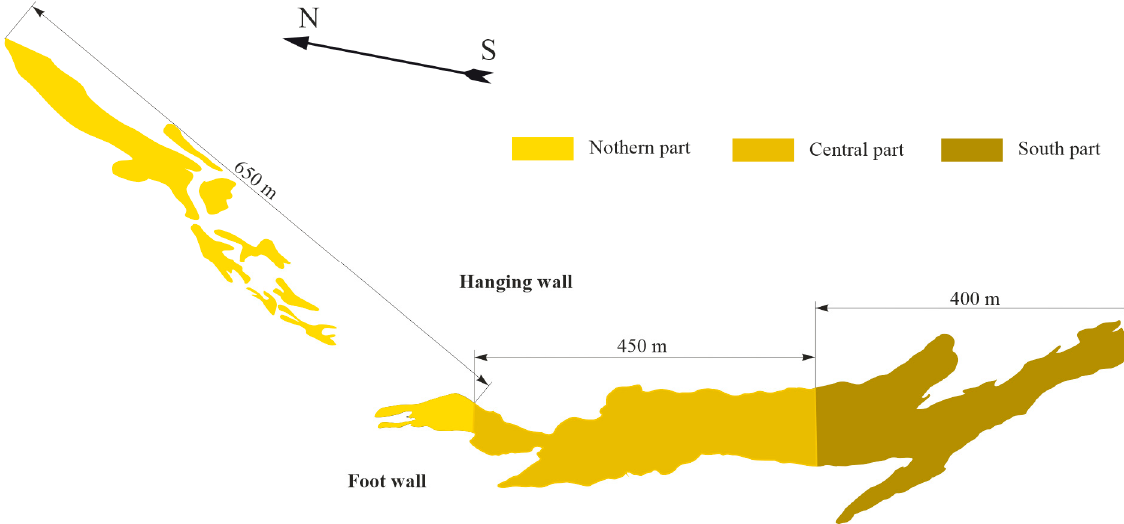
Figure 1. Characteristic zoning of an ore deposits with similar mining-and-geological conditions (740 m horizon section).